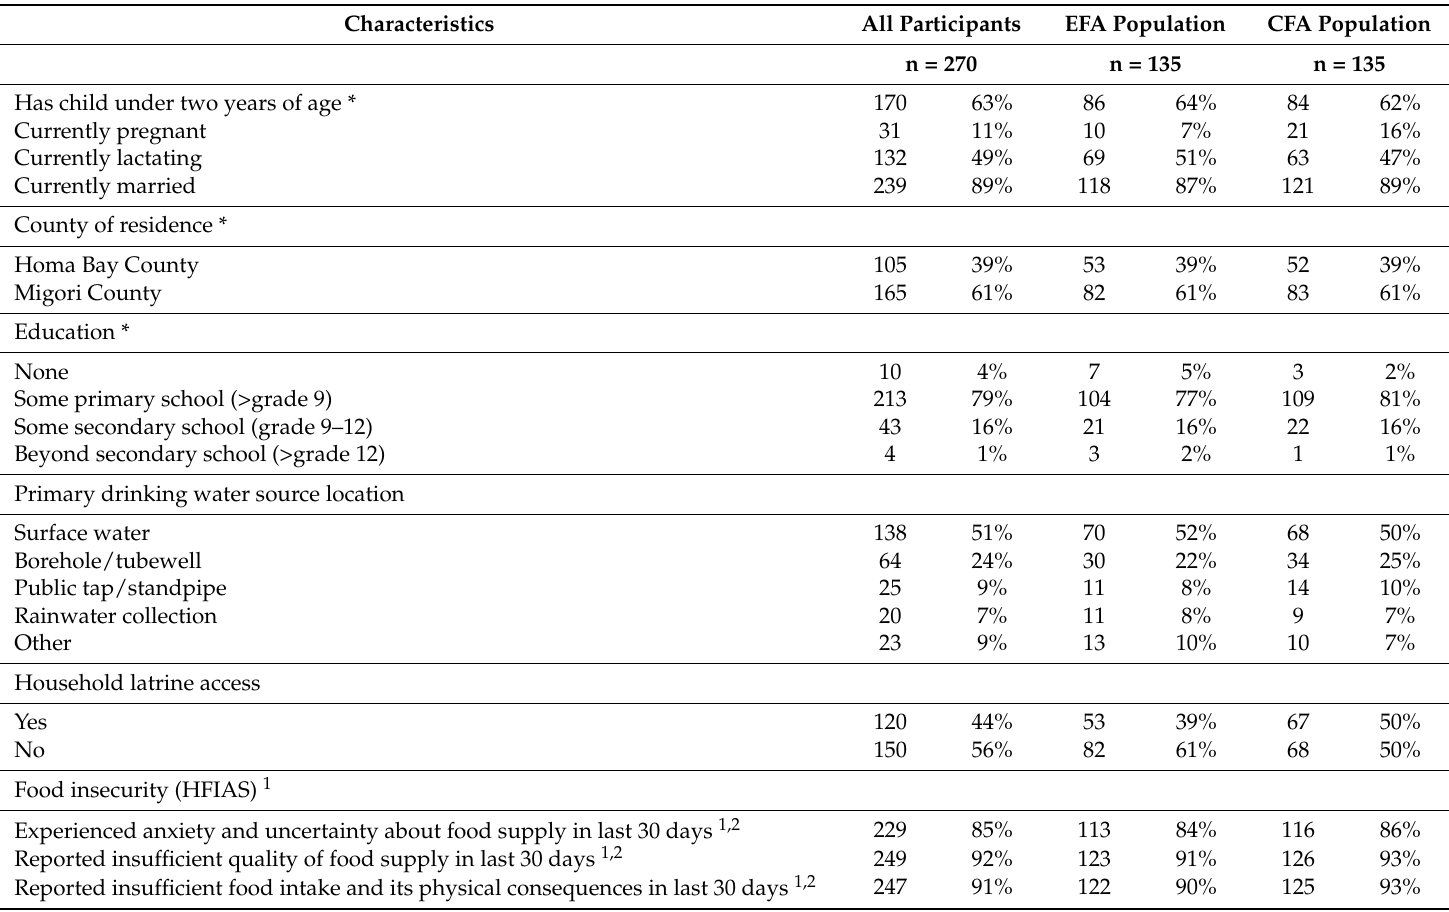
Table 2. Demographic characteristics of participants by population used for exploratory factor analysis (EFA) and confirmatory factor analysis (CFA).